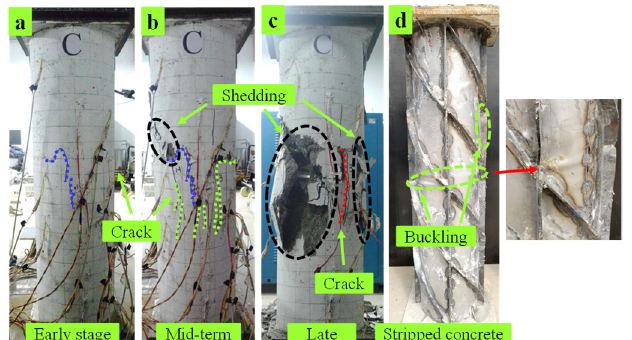
Figure 7. Damage phenomenon of C4. ( a ) Early-stage ( b ) Mid term ( c ) Late. ( d ) Stripped concrete.